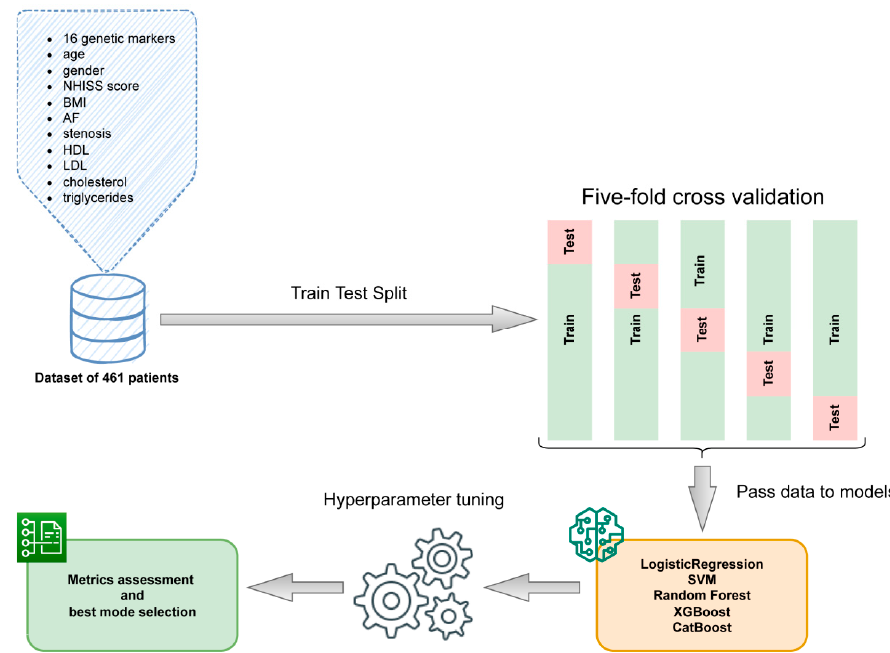
Figure 1. The machine learning pipeline.